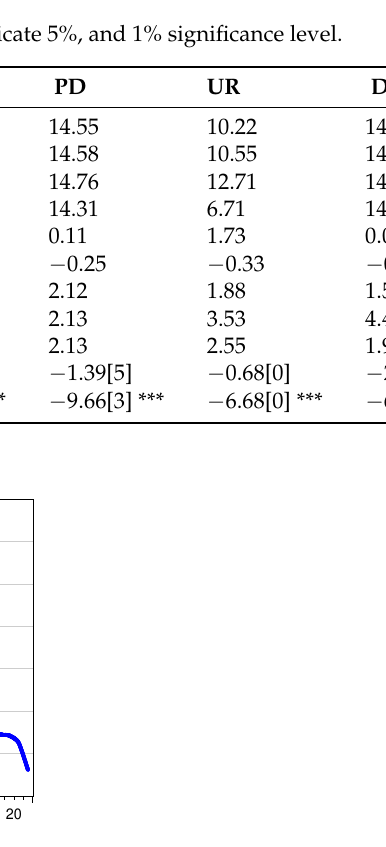
Figure 1. Non-performing ratio. The data sample spans from 2008Q3 to 2020Q4. Source: CEIC Data.